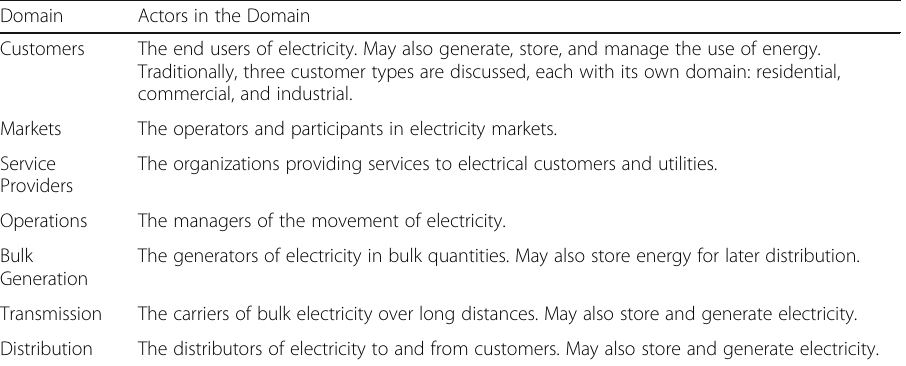
Table 9 Domains and Actors in the Smart Grid Conceptual Model (The National Institute of Standards and Technology (NIST) 2010) Domain